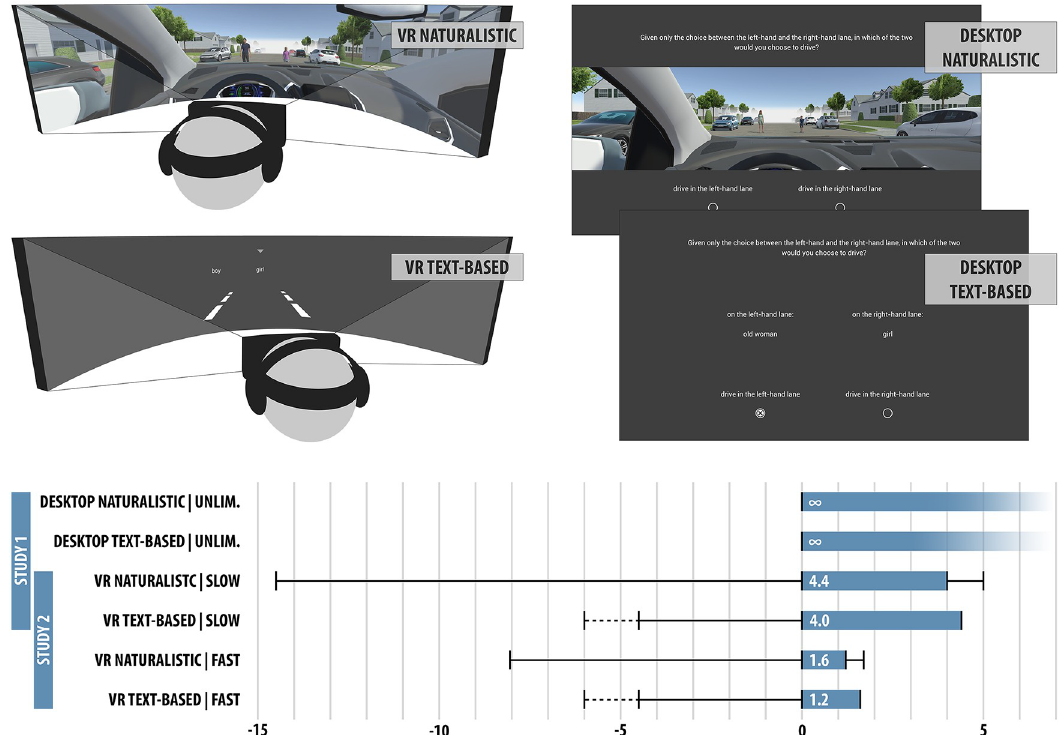
Fig 1. Overview of the experimental conditions and time lines. Black T-lines on the left indicate trial and control onsets, dashed lines indicate variable onset times. Blue bars indicate response time windows from visibility onset of the obstacles (VR: appearing from the fog) until car control offset, and black T-lines on the right indicate the time the car kept moving after control offset, i.e., the end of the trial. VR conditions featured an additional 1.5s of fade-to-black time (not indicated in the graphic).